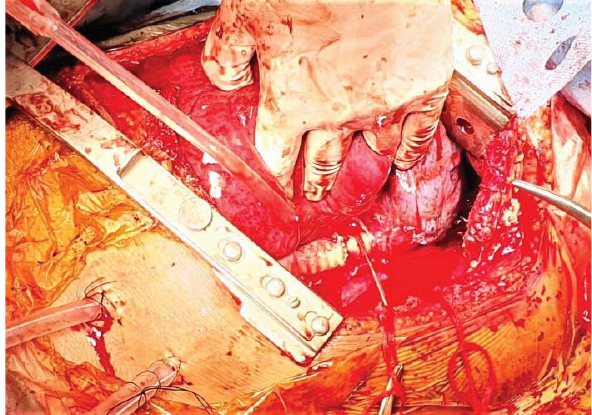
Figure 2. Intraoperative image showing interposed Dacron graft